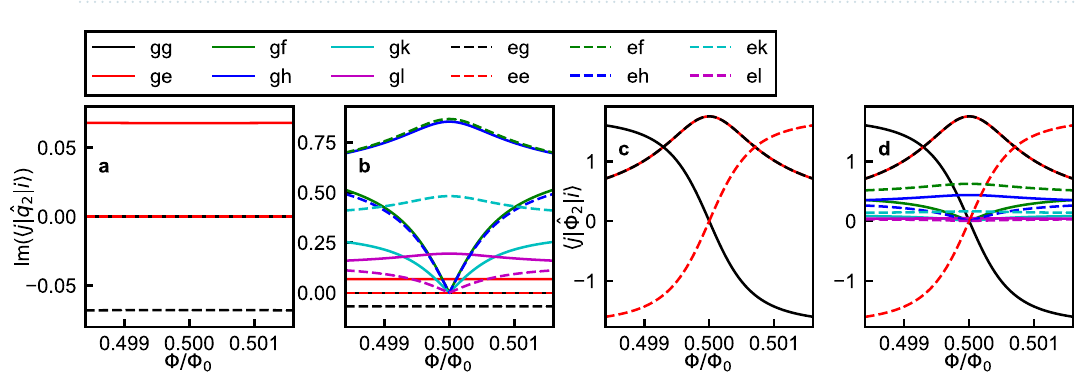
Figure 5. Parameters of ˆ H R obtained from the relations described in Table 1, (red solid lines) and by fitting the spectra of ˆ H circ up to the third excited state to ˆ H R (black dashed lines) as a function of L c . Panels ( a – d ) respectively correspond to the oscillator frequency ω , qubit frequency (cid:31) q , coupling strength g , and persistent current I p in ˆ H R . ( e ) The average of the squares of the residuals in the least-squares method for obtaining the 2 ( i = 1, 2, and 3). δω 0 i /( 2 π) parameters of ˆ H R by fitting, [ ]